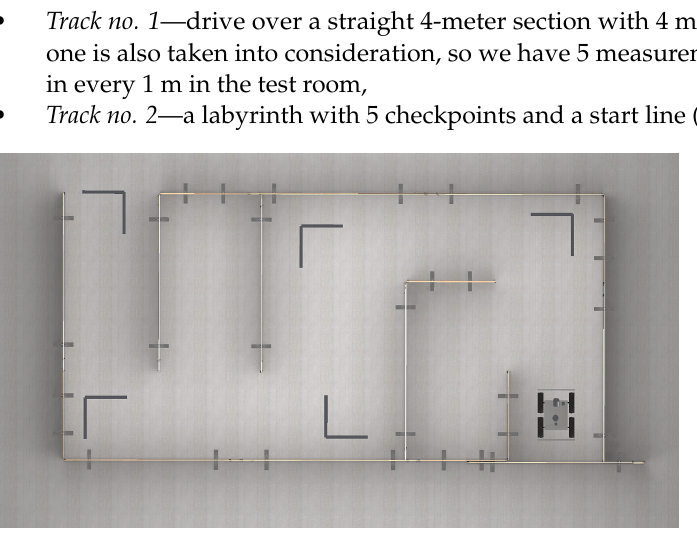
Figure 6. Track no. 2: A labyrinth setup with 5 checkpoints and a start line used for the